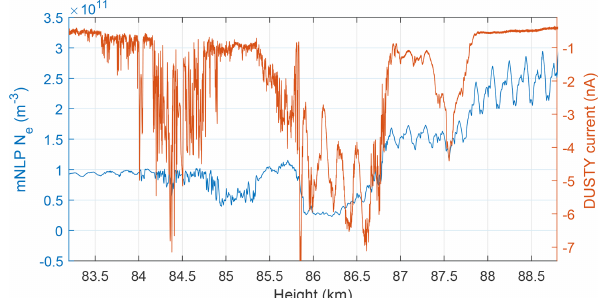
Figure 10. Comparison of electron density measure by the mNLP probes (blue) and DUSTY bottom plate current